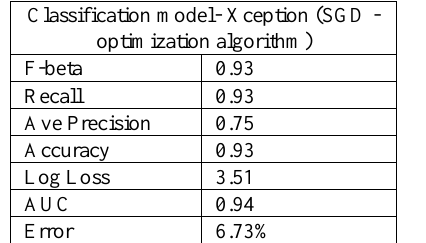
Table 4 . Operation correctness of classifier